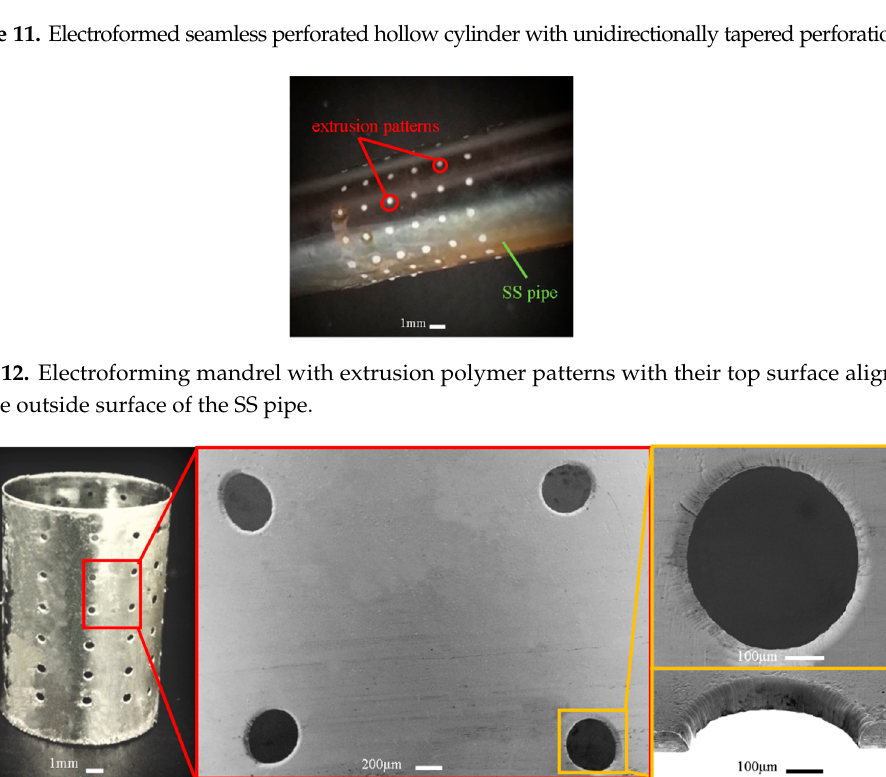
Figure 13. Seamless hollow cylinder with unidirectionally tapered perforations based on over-growth